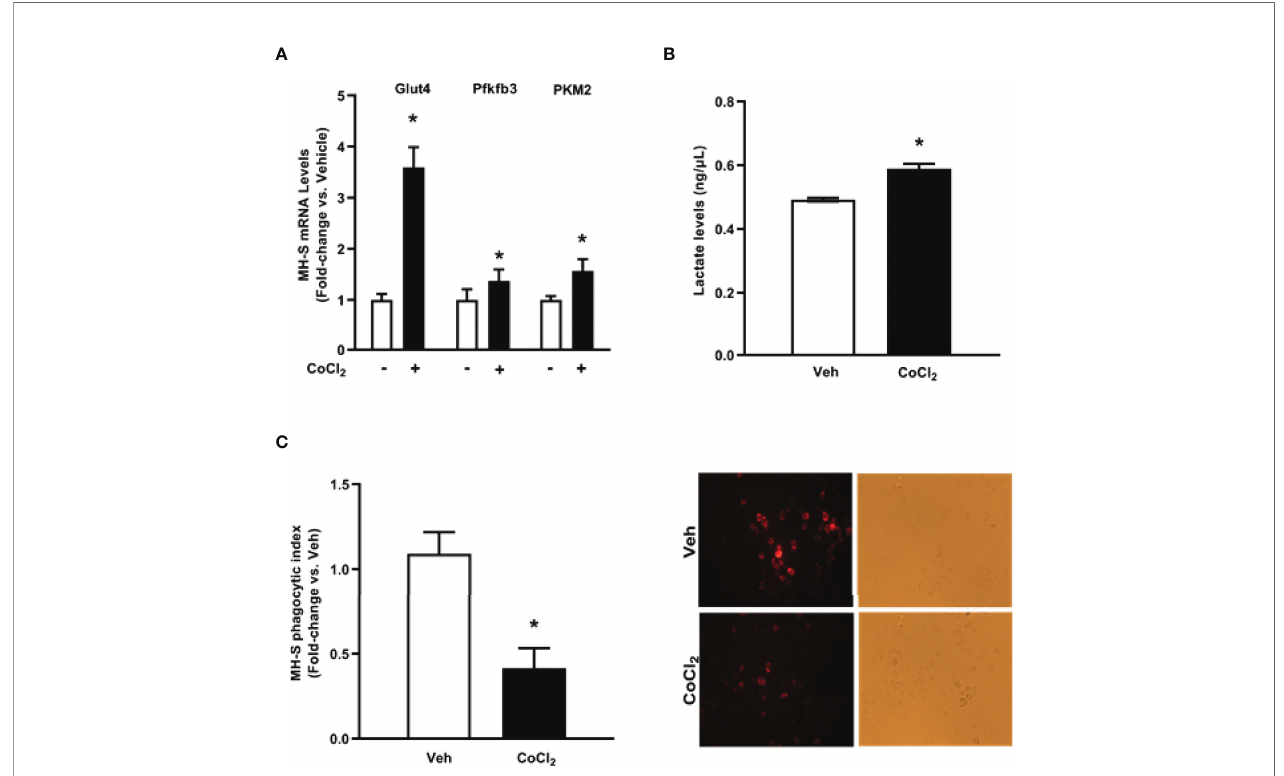
FIGURE 6 | Cobalt chloride induces expression of glycolytic proteins and lactate levels and causes phagocytic dysfunction in MH-S. MH-S were exposed to either vehicle (Veh) or cobalt chloride (CoCl 2 , 25 m M) for 4 hours. (A) mRNA levels of glucose transporter (Glut)4, 6-phosphofructo-2-kinase/fructose-2,6-bisphosphatase 3 (Pfkfb3), and pyruvate kinase 2 (PKM2) were measured by qRT-PCR, in duplicate, normalized to GAPDH, and are expressed as mean±SEM, relative to control (n = 4-6). (B) Protein isolated from MH-S was used to evaluate lactate levels via lactate assay kit and are expressed as mean±SEM, relative to vehicle (n = 6). * p < 0.05 versus vehicle. (C) Phagocytic index was calculated from the percentage of cells positive for bacterial uptake multiplied by the RFU of S. aureus per cell. Values are expressed as mean±SEM relative to vehicle (n = 5). Representative fl uorescent and bright fi eld images have been provided. * p < 0.05 versus treatment prevented the EtOH-induced glycolytic shift in MH-S ( Figure 9A ). Treatment with PIO also reversed EtOH- induced increases in the MH-S glycolytic bioenergetics parameters, glycolytic pro fi ling ( Figure 9B ), glycolysis ( Figure 9C ), glycolytic capacity ( Figure 9D ), glycolytic reserve ( Figure 9E ), and non-glycolytic acidi fi cation ( Figure 9F ). Similarly, PIO treatment prevented the glycolytic shift in mAM isolated from EtOH-fed mice ( Figure 10A ). Treatment with PIO also reversed EtOH-induced increases in the mAM glycolytic bioenergetics parameters, glycolytic pro fi ling ( Figure 10B ), glycolysis ( Figure 10C ), glycolytic capacity ( Figure 10D ), glycolytic reserve ( Figure 10E ), and non-glycolytic acidi fi cation ( Figure 10F ). Collectively, these data show that AM glycolytic PIO treatment.